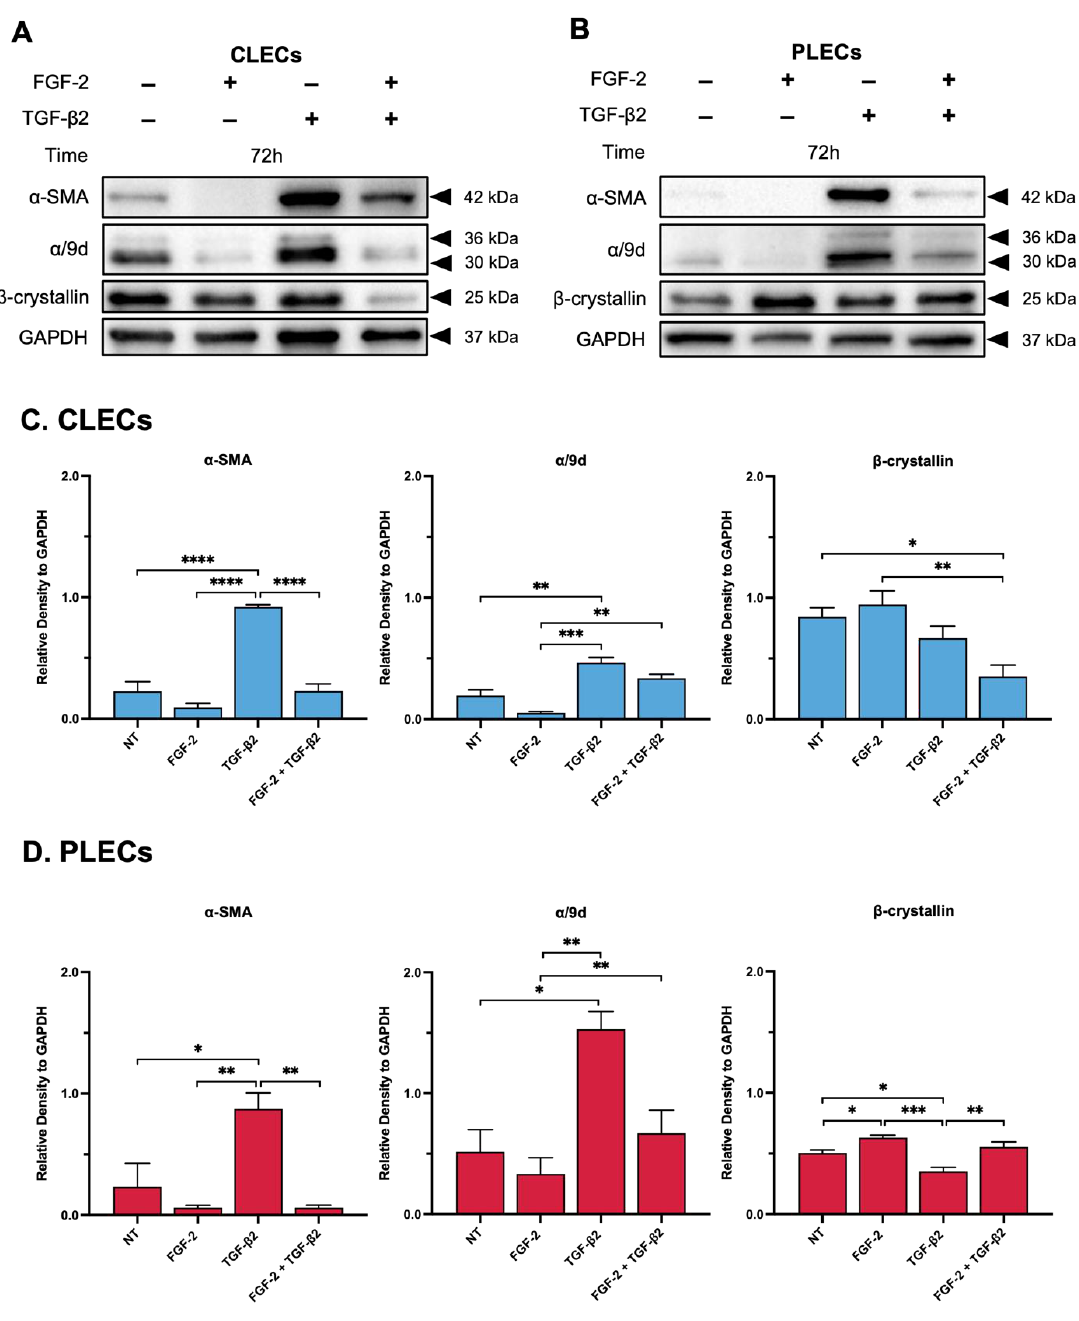
Figure 4. FGF-2 modulates levels of different protein markers in TGF- β2 -treated LECs. Representative Western blot for alpha-tropomyosin ( α /9d), α -SMA, and β -crystallin in the control (non-treated, NT), FGF-2, TGF- β2 , and FGF-2/TGF- β2 cotreated CLECs ( A , C ) and PLECs ( B , D ). Protein levels were normalized relative to GAPDH levels ( C , D ). One-way ANOVA with the mean ± SEM and post-hoc Tukey’s multiple comparisons test (* p < 0.0332, ** p < 0.0021, *** p < 0.002, **** p < 0.001). Alpha-Tropomyosin. α/9d levels were significantly elevated only in the CLECs and PLECs of the TGF- β2 -treated explants, when compared to the corresponding cells of all other treatment groups (Figure 4A – D). For the CLECs, levels of α/9d in the control ex- plants were reduced in both the FGF-2 ( p = 0.0924)- and FGF-2/TGF- β2 -treated explants ( p = 0.0959) and were significantly reduced when compared to the elevated α/9d levels found